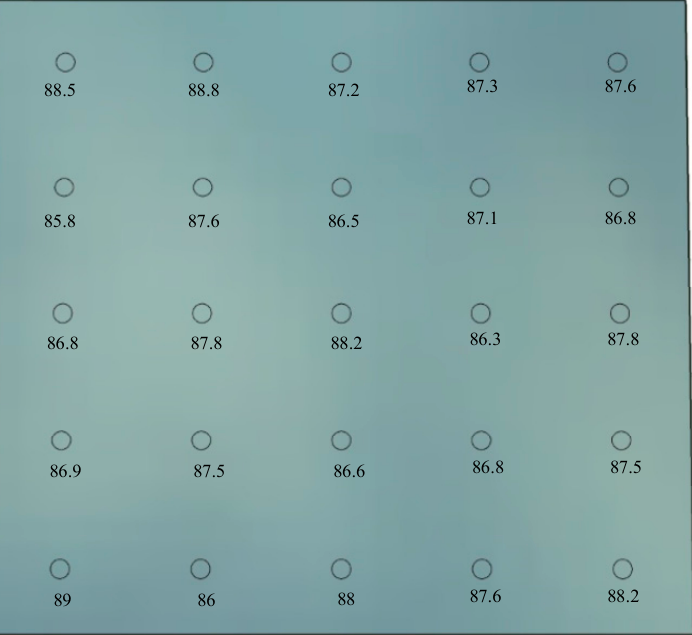
Figure 11. Manual measurement result of light transmittance after 3.5 days of dust deposition. Table 9. Results of the simulation and measurement of transmittance and the number of dust particles in each